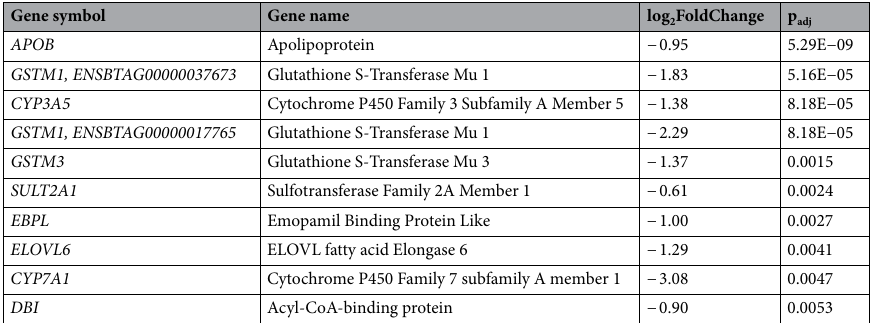
Table 1. Top 10 significantly DEGs (sorted by p adj , ascending) in the differential expression analysis CDC cows versus CDF